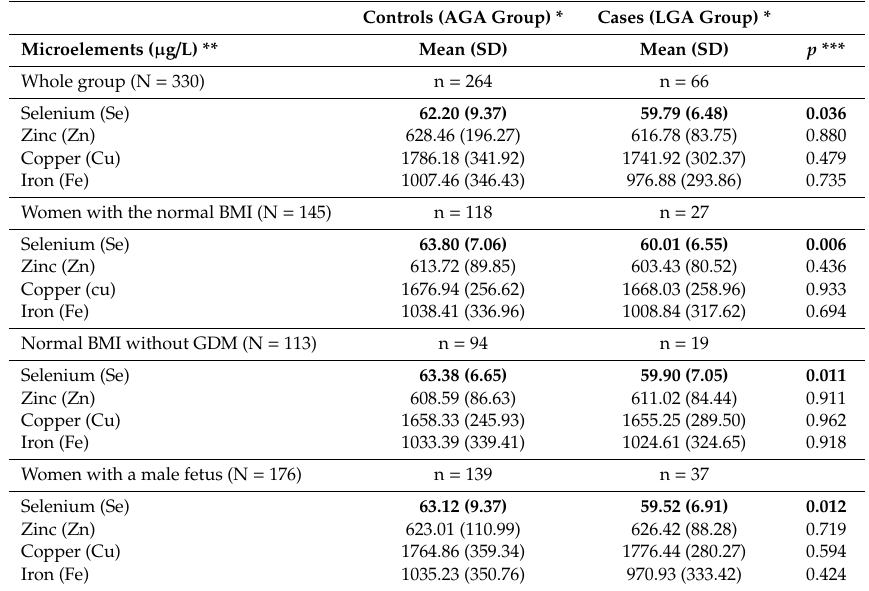
Table 2. The characteristics of microelements’ concentrations in the AGA and LGA group in the whole group and in